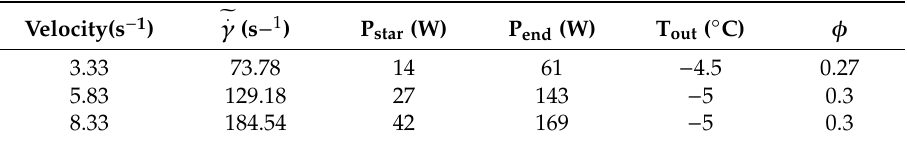
Table 2. Estimated shear rate values for di ff erent SSHE agitation rates, power consumed at each rate and estimated ice